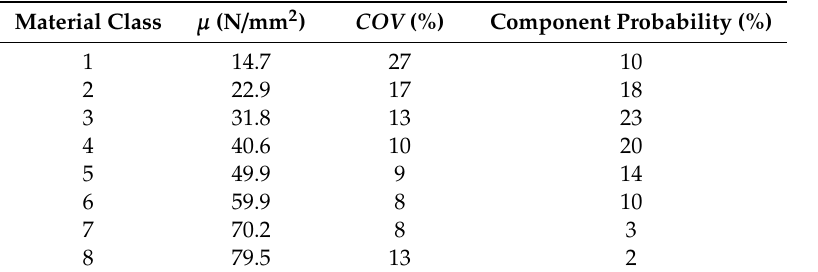
Table 1. Concrete compressive strength—statistical parameters µ and COV of the Gaussian Mixture Model (GMM) and probability of each component.